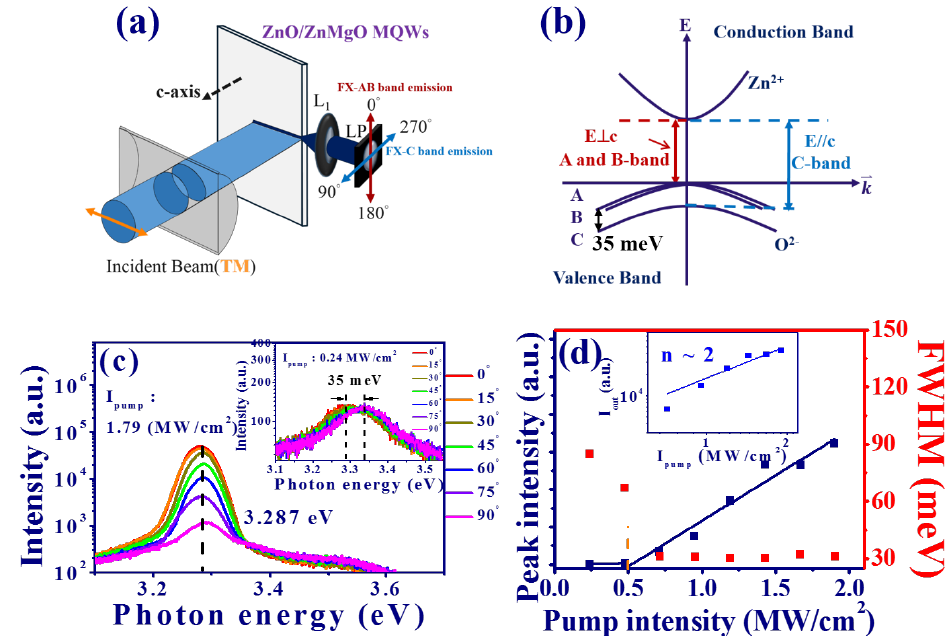
Figure 2. ( a ) Schematic illustration of the edge emission from the MQWs through the pump of a Q-switched laser, ( b ) band diagram of ZnO. ( c ) Polarization-dependent ASE and SPE spectra (inset) as θ increases from 0 ◦ to 90 ◦ , and ( d ) peak intensity and FWHM of the emission spectrum from the MQWs versus pump intensity using the TM mode pump polarization. (Inset: logarithm intensity of ASE as a function of pump intensity.